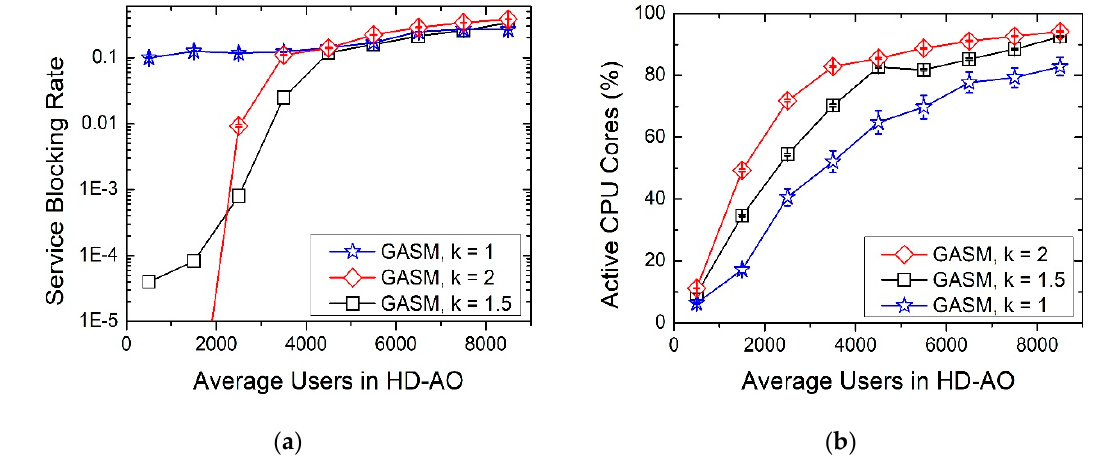
Figure 4. Network planning results using GASM with k = 1, k = 1.5 and k = 2 : ( a ) Service blocking rate, ( b ) percentage of CPU cores in use.